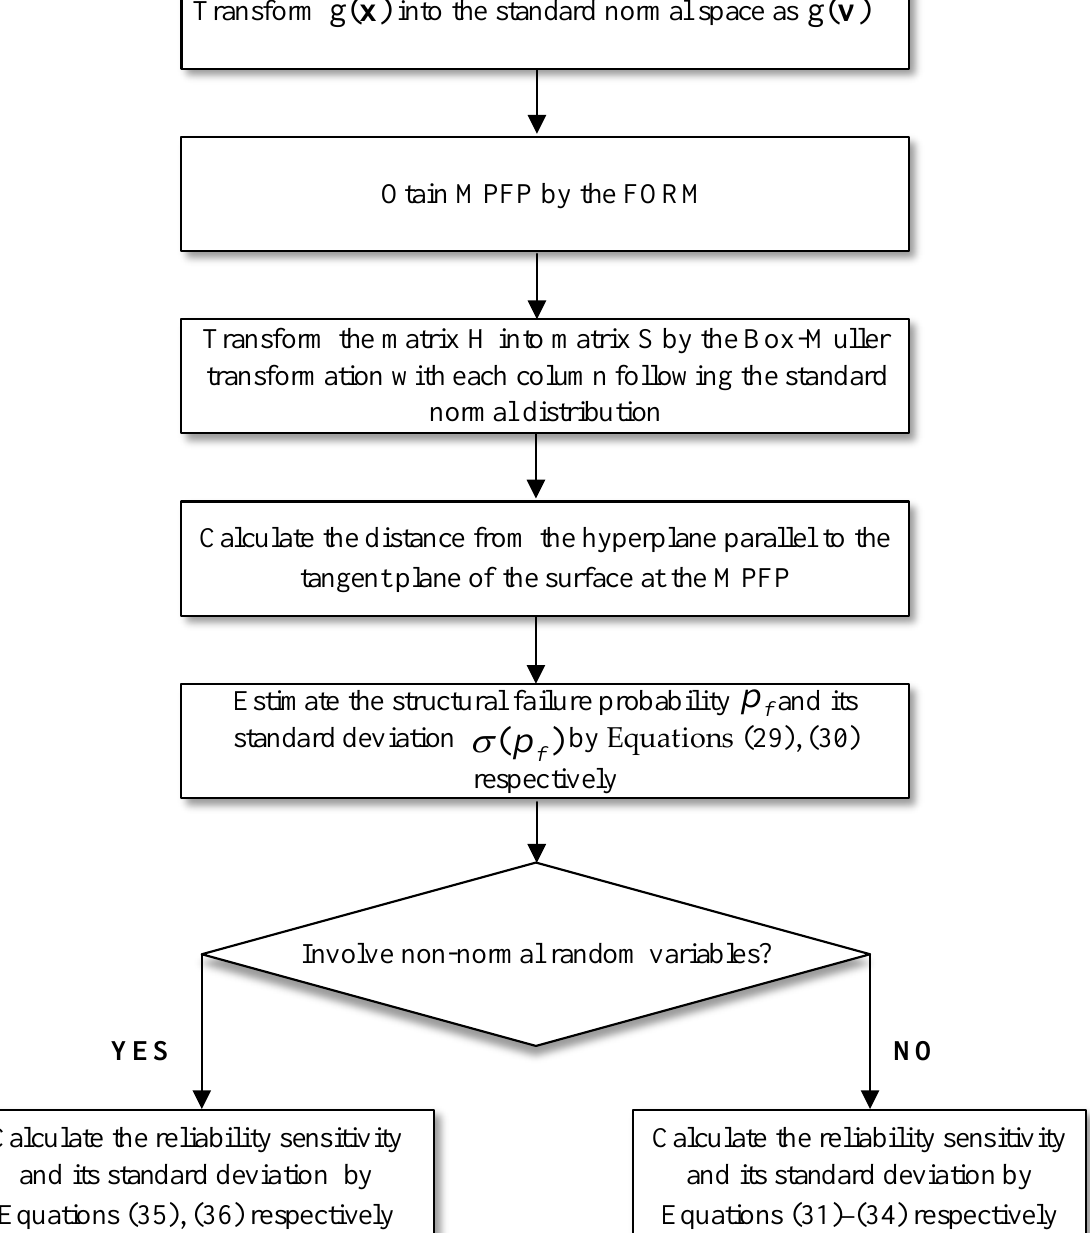
Figure 3. Procedure of structural reliability and its sensitivity analysis.